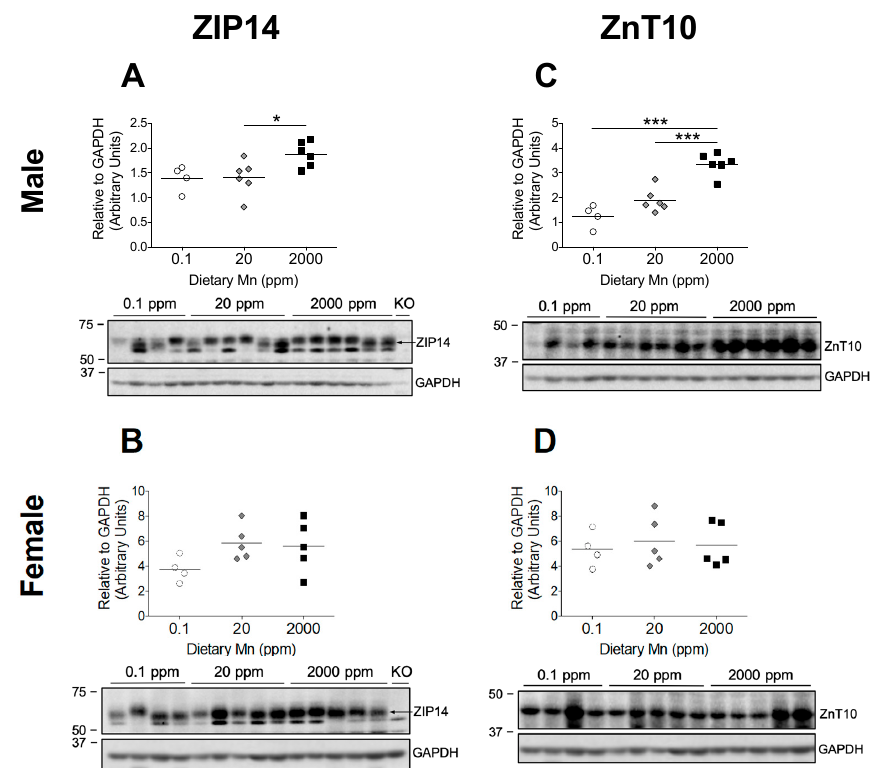
Figure 7. Comparison of transporter protein levels in the small intestine. Expression of (A and B) ZIP14 and (C and D) ZnT10 in male and female mice on 0.1, 20, and 2000 ppm Mn diets ( n = 4–6/sex). Proximal sections of the small intestine were obtained during sacrifice at 12 weeks of age and samples that did not degrade during homogenization were analyzed via western blot. Protein quantifications were performed using GAPDH as a loading control. ZIP14 blots also include results from an age-matched Zip14 knockout (KO) mouse as a control (fed traditional rodent diet). Data expressed as mean ± SEM. * p < 0.05, *** p < 0.001.